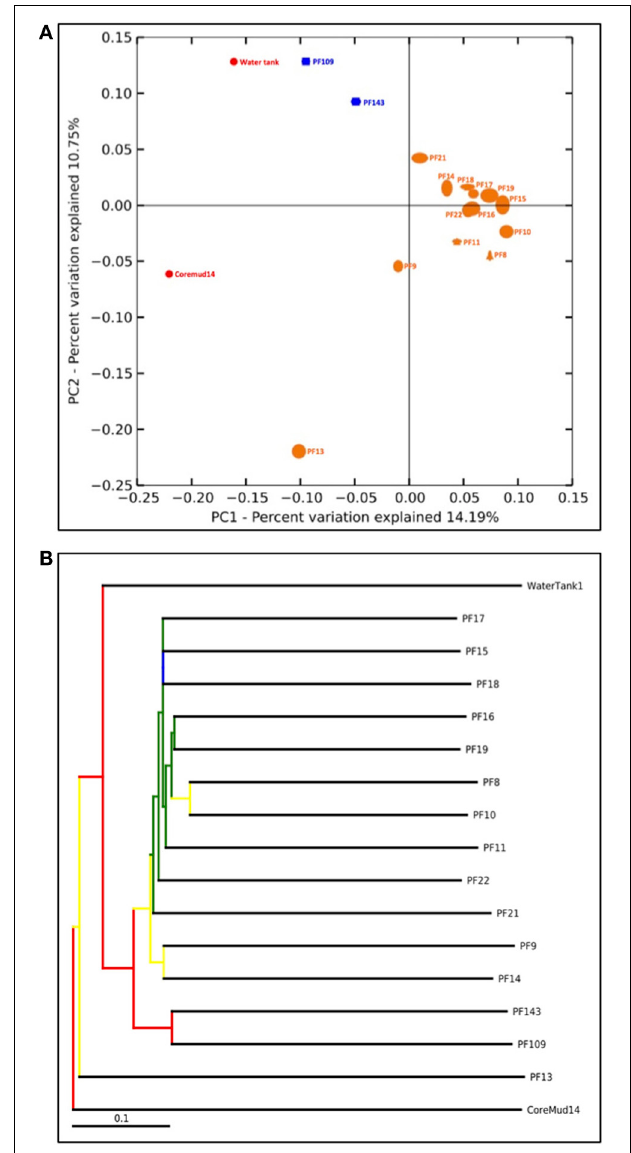
FIGURE 5 | Beta-diversity analyses of Paaratte Formation groundwater, drilling mud and storage tank microbial communities. One thousand nine hundred and eighty-two sequences from each sample were selected at random and processed for a jackknifing analysis and represented as (A) a UniFrac Principal Co-ordinate Analysis plot according to its first two principal coordinates, and (B) a bootstrap-supported hierarchical clustering